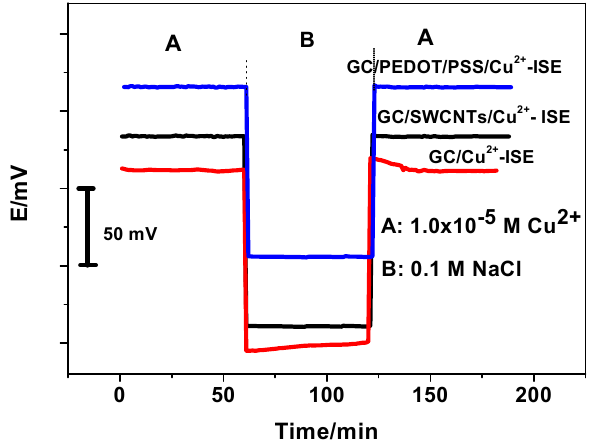
Figure 4. Water film tests of the solid-contact Cu 2+ -ISEs and of the CWE. At t = 1 h, the solution of the primary ion (10 −5 M Cu 2+ ) was exchanged to 10 −1 M NaCl. At t = 2 h, the initial solution was inserted.